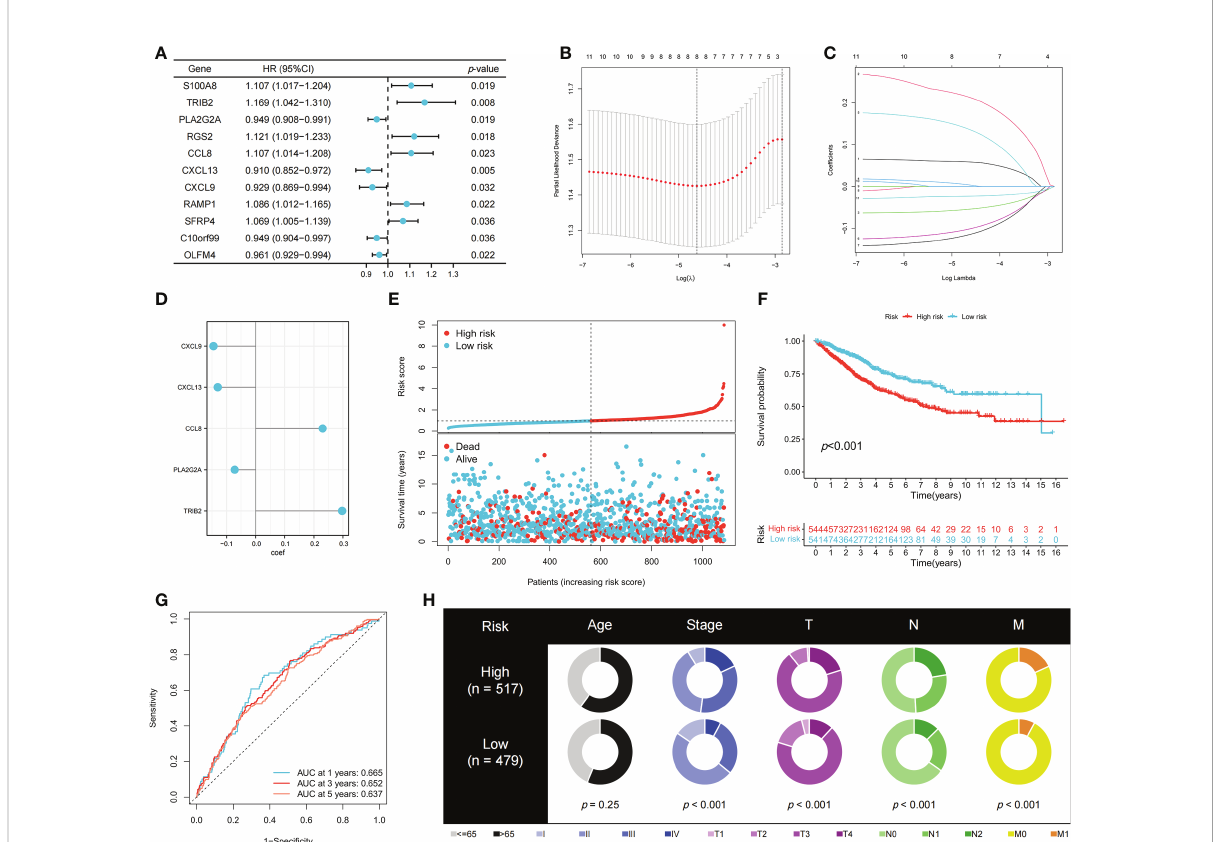
FIGURE 3 Construction of the prognostic signature. (A) PRDEGs were identi fi ed using univariate Cox regression analysis. (B, C) The LASSO regression analysis and partial likelihood deviance on the prognostic genes. (D) The coef fi cient values of the multivariate Cox regression. (E) Risk score and survival outcome of each case. KM (F) and ROC (G) curves showing the prognostic value in the training cohort. (H) Pie charts showing the Chi- squared test of clinicopathologic factors in high- and low-risk